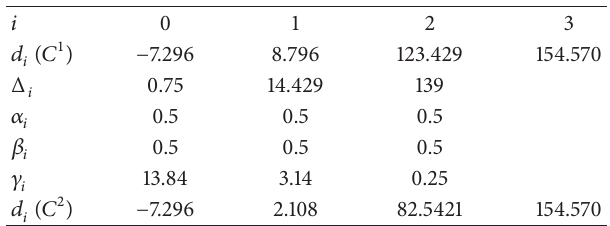
Table 4: Numerical results.